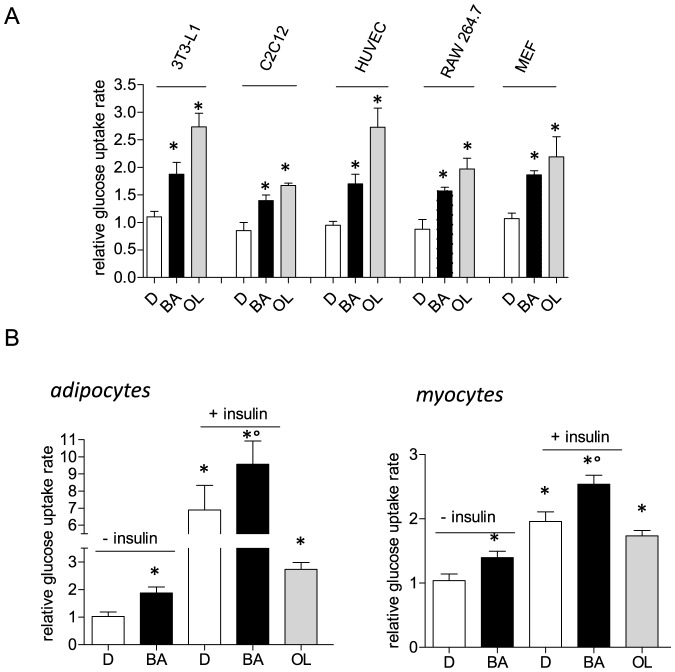
Cellular glucose uptake rate upon exposure to BA.(A) Different cell types (differentiated adipocytes (3T3-L1), differentiated myotubes (C2C12), endothelial cells (HUVEC), macrophages (RAW264.7) and murine embryonic fibroblasts (MEF)) were treated with 10 µM BA (+) or 0.1% DMSO (−) for 16 h before their cellular glucose uptake rate was determined as described. Oligomycin A (OL, 2 µM for 4 h) served as positive control for increased basal glucose uptake. The bar graph depicts glucose uptake rates relative to the mean of the respective DMSO control (n = 3 (i.e. three independent experiments, each in triplicate); * p<0.05 vs DMSO ctrl, ANOVA). (B) Differentiated adipocytes (left) and myocytes (right) were treated with BA (10 µM) for 16 h prior to serum starvation and insulin stimulation (15 min; 3T3-L1: 15 nM insulin; C2C12: 100 nM insulin). Then cellular glucose uptake was determined. Bar graphs depict glucose uptake rates relative to the mean of the respective unstimulated vehicle control. (n = 3 (i.e three independent experiments, each in triplicate); mean + SD; * p<0.05 vs unstimulated DMSO ctrl, ° p<0.05 vs insulin-stimulated DMSO ctrl, two-way ANOVA, Bonferroni). Oligomycin A (OL, 2 µM for 4 h) served as positive control for increased basal glucose uptake.